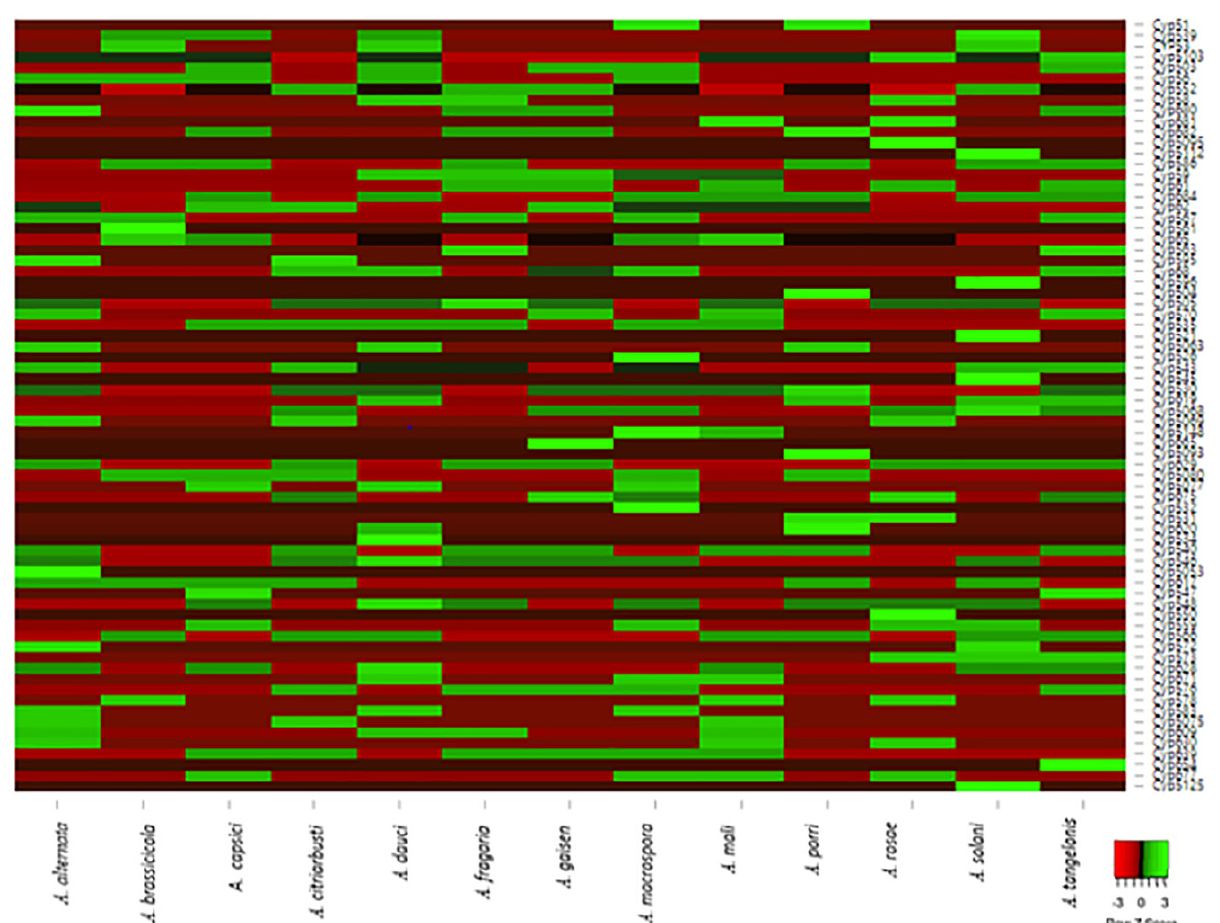
Figure 1. Heatmap showing the distribution of Cyp families (green) or absence (red) across thirteen (13) Alternaria species. The data used in generating this heat map are presented in Supplementary Data File S5.